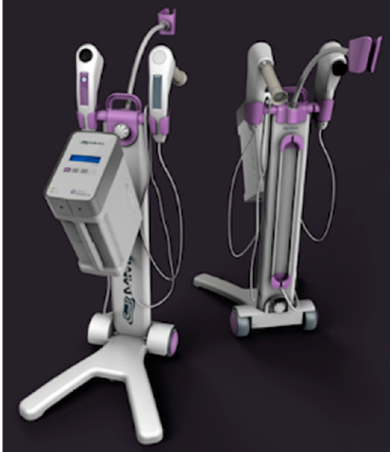
Figure 1. CerCa 150 System® in two different views, showing the front and the back of the device.